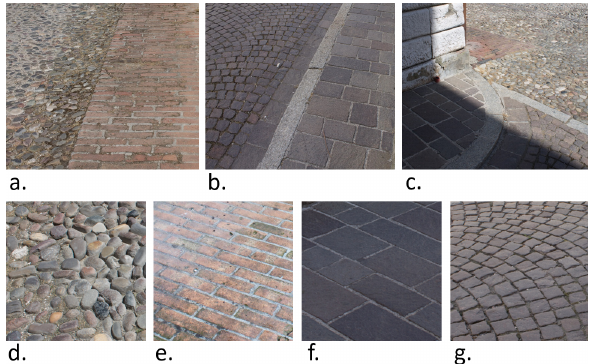
Figure 6. Paving materials in the case-study. a: combination of ”cobblestone” and ”bricks”, b: combination of ”sampietrini” and ”stone”, c: combination of ”sampietrini”, ”stone”, and ”cobblestone”, d:”cobblestone”, e:”bricks”, f:”stone”, g:”sampietrini”.